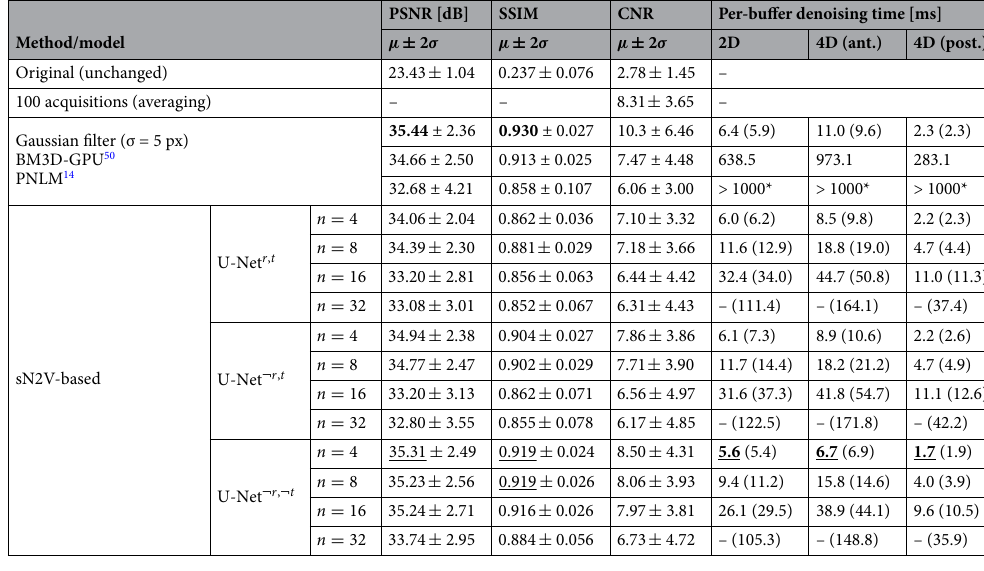
Table 2. Denoising performance and timings for different methods. The comparison shows reference scores, as well as different network configurations for our adapted structured Noise2Void (sN2V). Where possible, timings were determined by profiling. Overall best PSNR and SSIM and execution times are marked in bold, best scores when only comparing different network setups are underlined. Note that different imaging modes have different timing requirements (see Fig. 5 and Table 1), and not all listed timings allow stable execution over an extended time period. Timings in parentheses were determined using the TensorRT-integrated benchmark on the same GPU (NVIDIA Titan RTX). Timings for PNLM 14 ( ∗ ) could not be measured in a fair scenario, but exceeded seconds to even minutes when executed in MATLAB on a CPU.